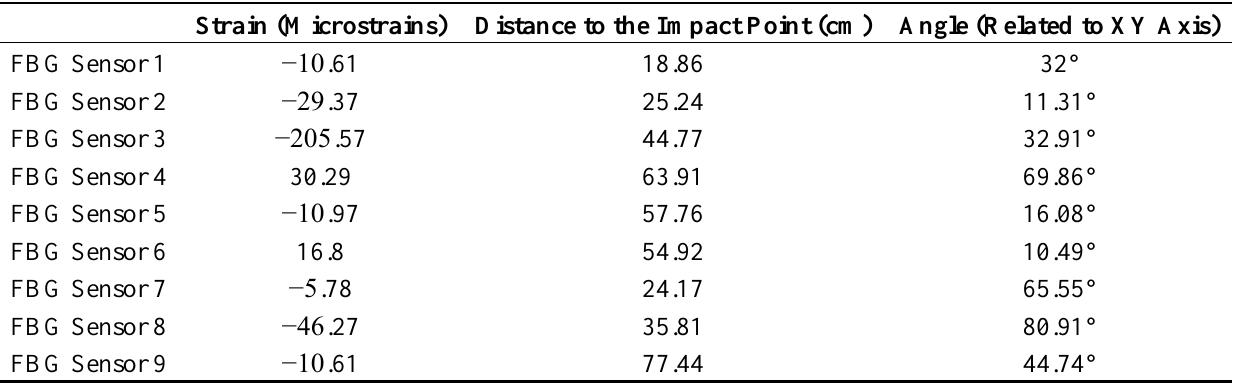
Table 4. Residual strain for the mass of 10 kg when it is on the Impact Point 1 after the impact. Strain